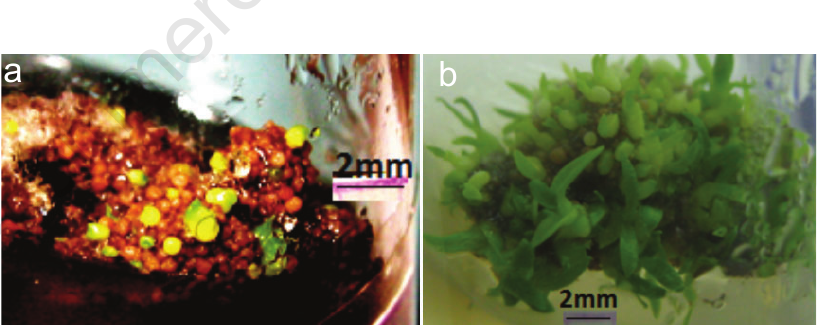
Figure 3. (a) PLB formation on media containing BAP (0.5mg/L) and (b) subsequent plantlet formation.